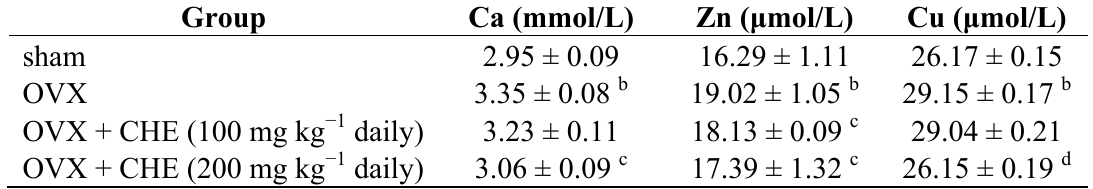
Table 3. Effect of Cistanches Herba extract treatment on blood Ca, Zn and Cu levels.